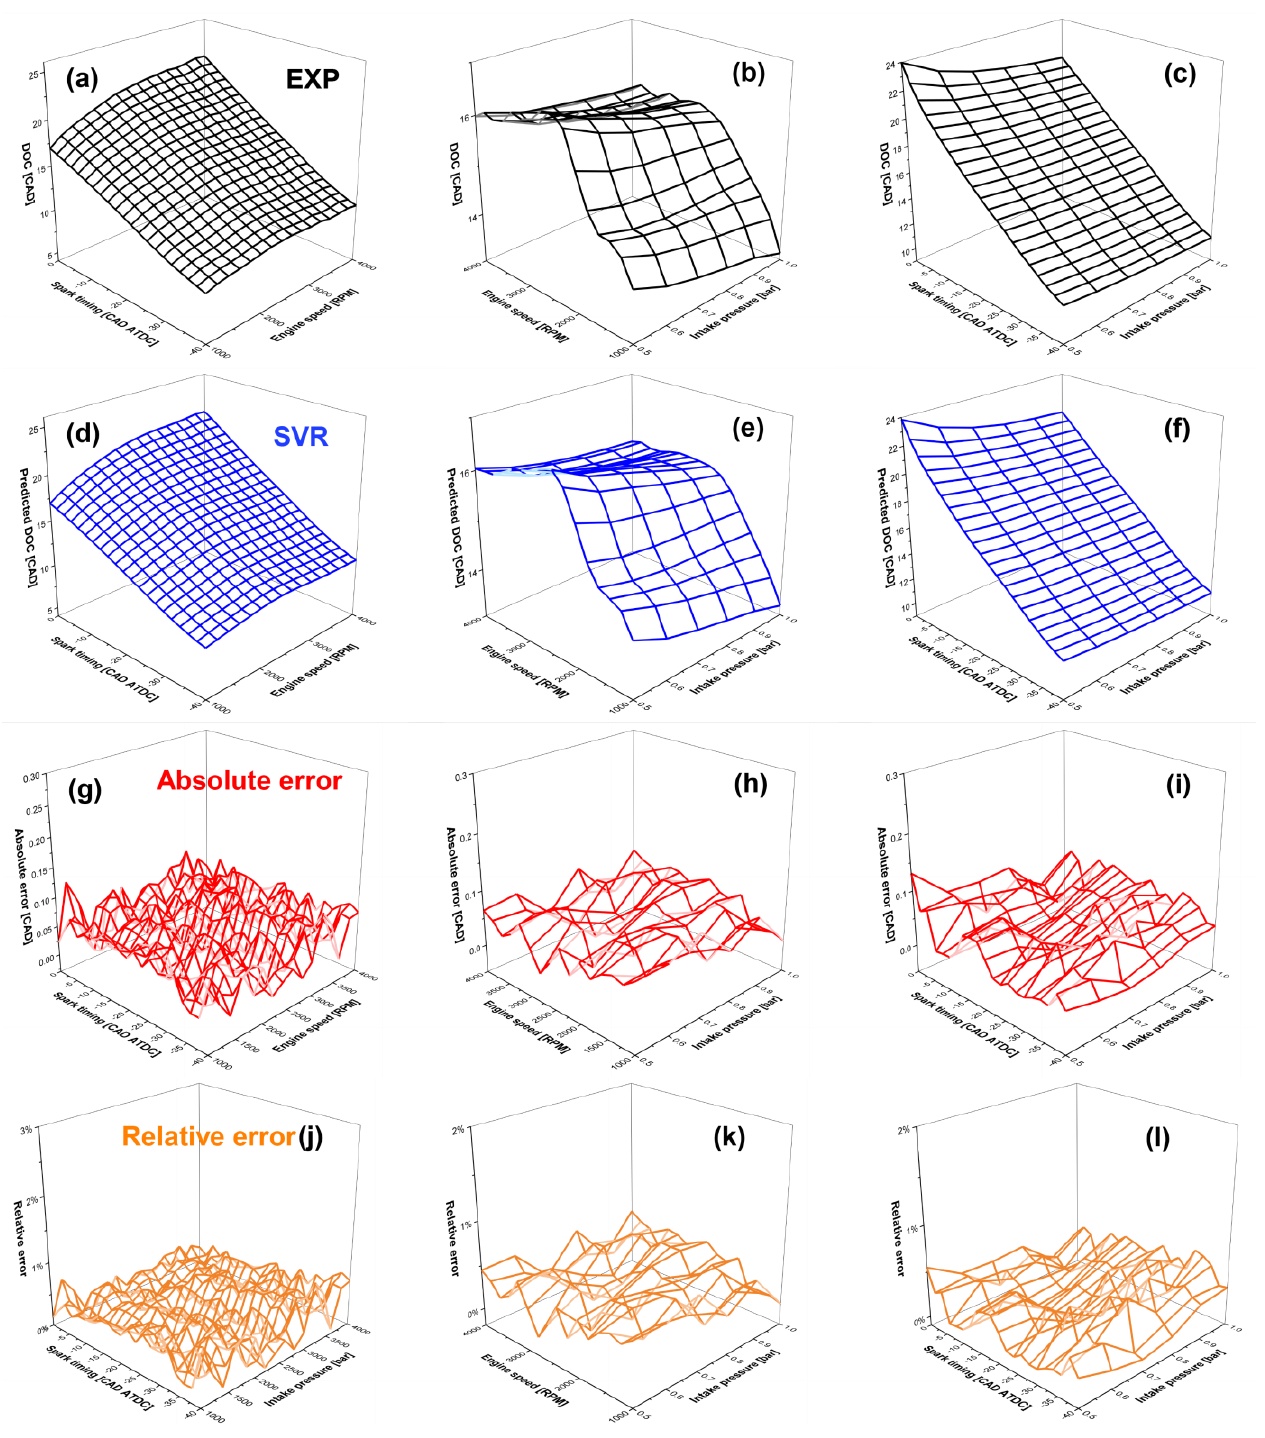
Figure 17. DOC versus different operation parameters combination. ( a , d , g , j ) Prediction performance when spark timing and engine speed change (intake pressure = 1 bar); ( b , e , h , k ) prediction performance when engine speed and intake pressure change (spark timing = − 20 CAD ATDC); and ( c , f , i , l ) prediction performance when spark timing and intake pressure change (engine speed = 2600 RPM).